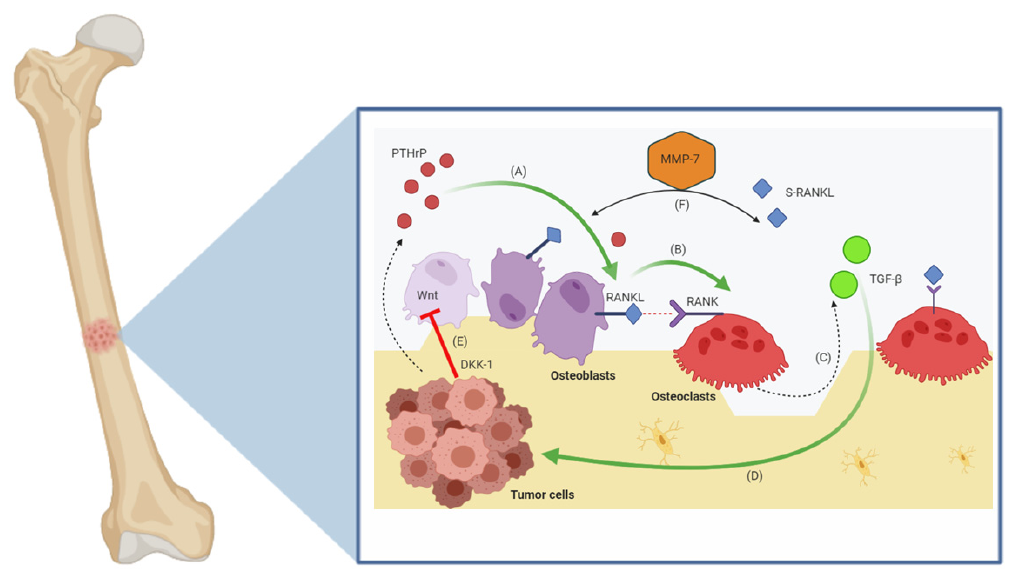
Figure 1. “Vicious cycle” in bone metastases. Bone metastatic prostate cancer cells secrete factors (e.g., parathyroid hormone-related protein, PTHrP) that upregulate receptor activator of nuclear factor kappa-B ligand (RANKL) expression by osteoblasts ( A ), which interacts with RANK receptor on osteoclast progenitors causing bone resorption through osteoclastic differentiation ( B ). This interaction consequently contributes to the release and activation of transforming growth factor- β (TGF β ) ( C ), which is stored in mineralized bone matrix and further promote tumor growth ( D ), leading to a “vicious cycle”. In addition, prostate cancer cells express the Wnt inhibitor Dickkopf-1 (DKK-1) and osteoblast progenitors respond to this negative regulator via inhibition of osteoblastogenesis process ( E ). Finally, the secretion of MMP-7 results in the solubilization of RANKL in the bone microenvironment ( F ), which increases bone resorption.